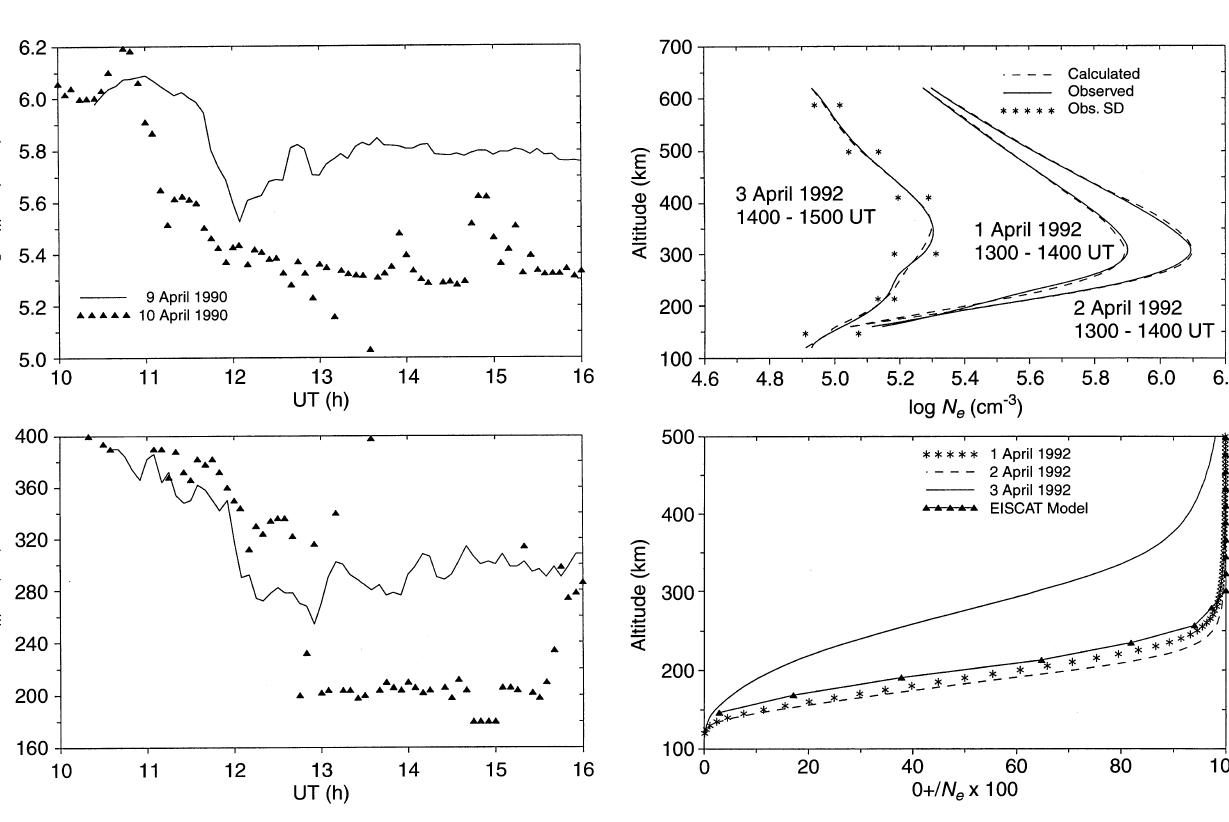
deviations) and calculated N ( h ) profiles for two geomagnetically quiet e (1, 2 April) and disturbed (3 April 1992) days. Bottom panel : calculated and EISCAT model [O + ]/ N height variations for the e